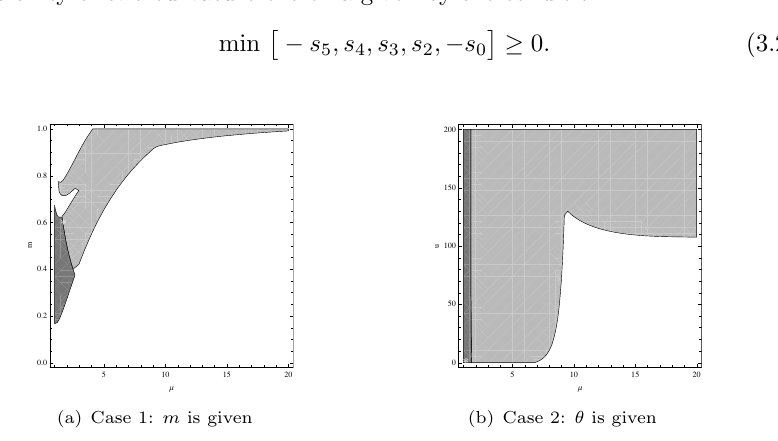
Figure 4. Regions for single (light gray) or double (dark gray) curvature extrema for an S-shaped transition